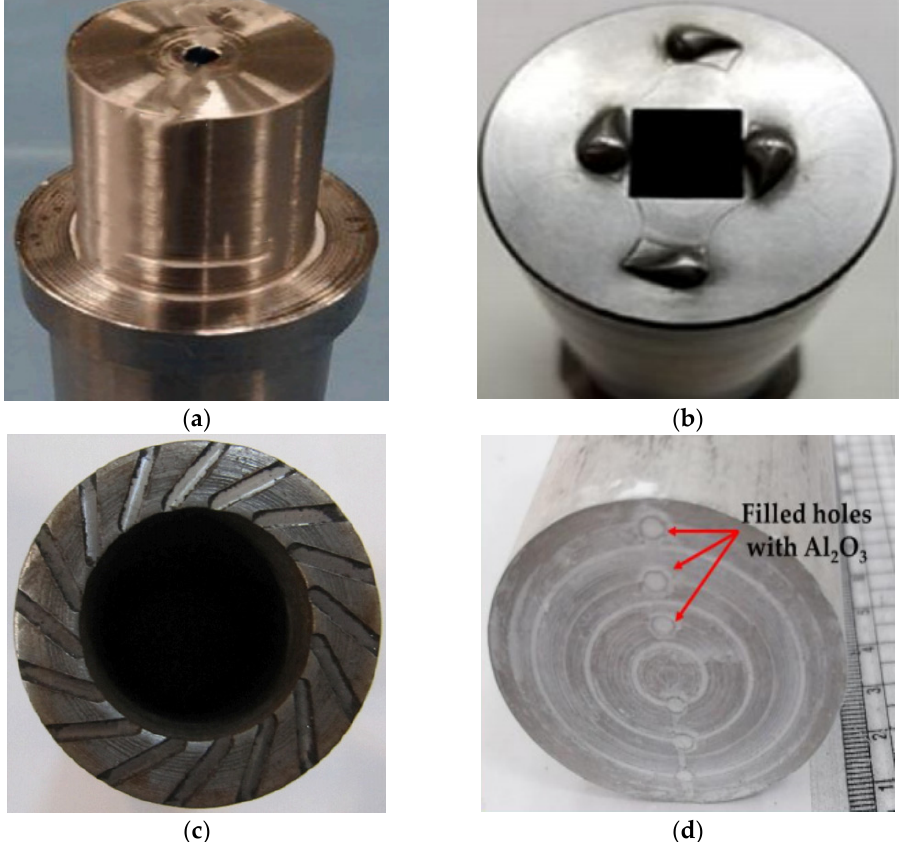
Figure 4. The different tools used for AFSD. ( a ) Flat tool [24]. ( b ) Protruding tool with bulges [25]. ( c ) Friction-forging AM tool [26]. ( d ) Consumable tool with reinforcing particles [23].